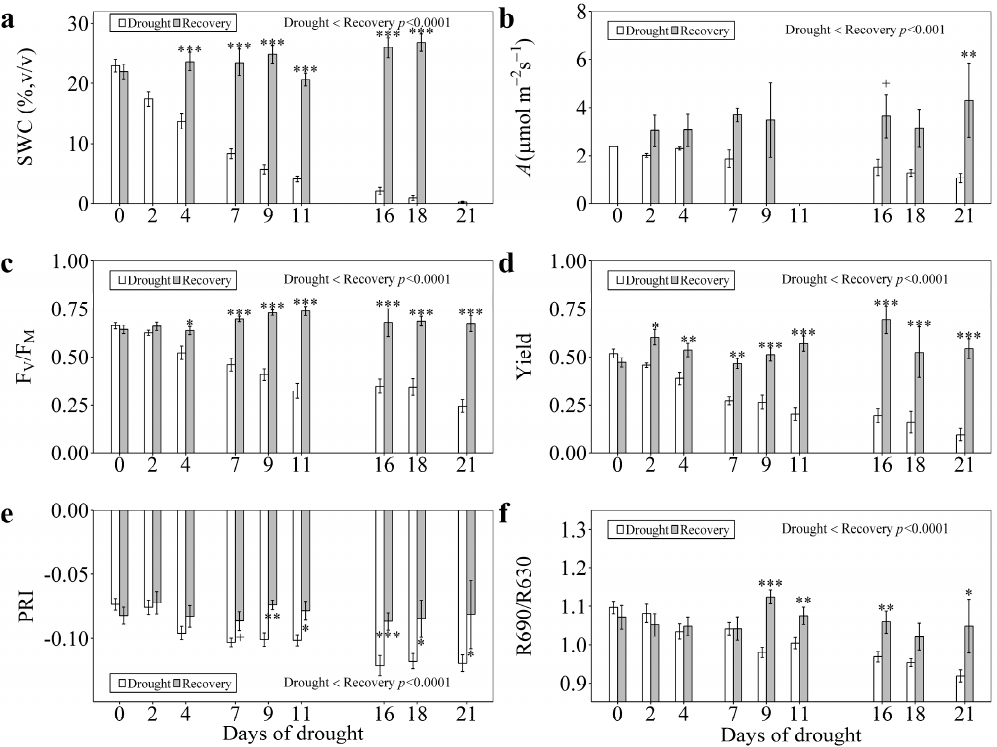
Figure 3. Changes in SWC ( a ), A ( b ), F V /F M ( c ), Yield ( d ), PRI ( e ) and R690/R630 ( f ) in response to nine different drought levels and corresponding recovery treatments for Quercus ilex . The significances were denoted as + p < 0.1, * p < 0.05, ** p < 0.01 and *** p < 0.001.